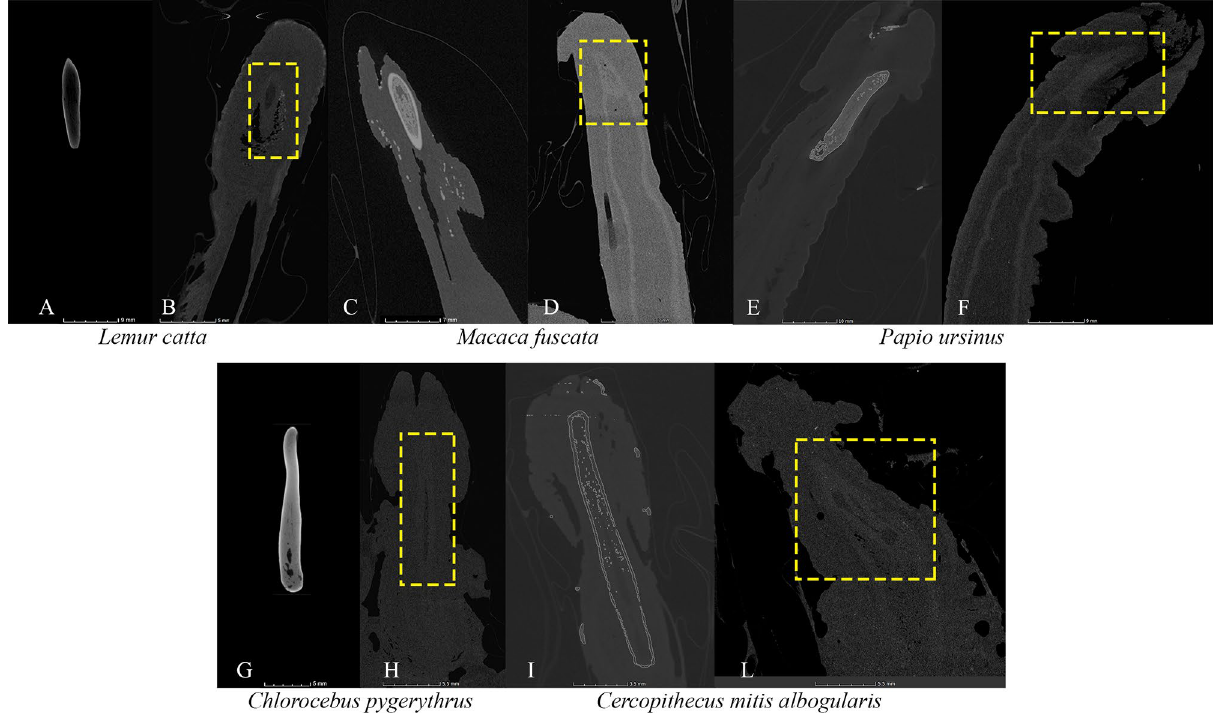
Figure 5. Doubtful cases of baculum occurrence in micro-CT scanned samples. Reconstructed micro-CT slices of doubtful cases of baculum occurrence: specimens showing a baculum on the left ( A,C,E,G,I ); in specimens ( A,G ) the penile bone was extracted from soft tissues) compared to conspecific doubtful cases highlighted with dashed yellow lines on the right ( B,D,F,H,L ). Not to scale. Figure generated in myVGL (v. 3.0, https:// https:// www. volum egrap hics.